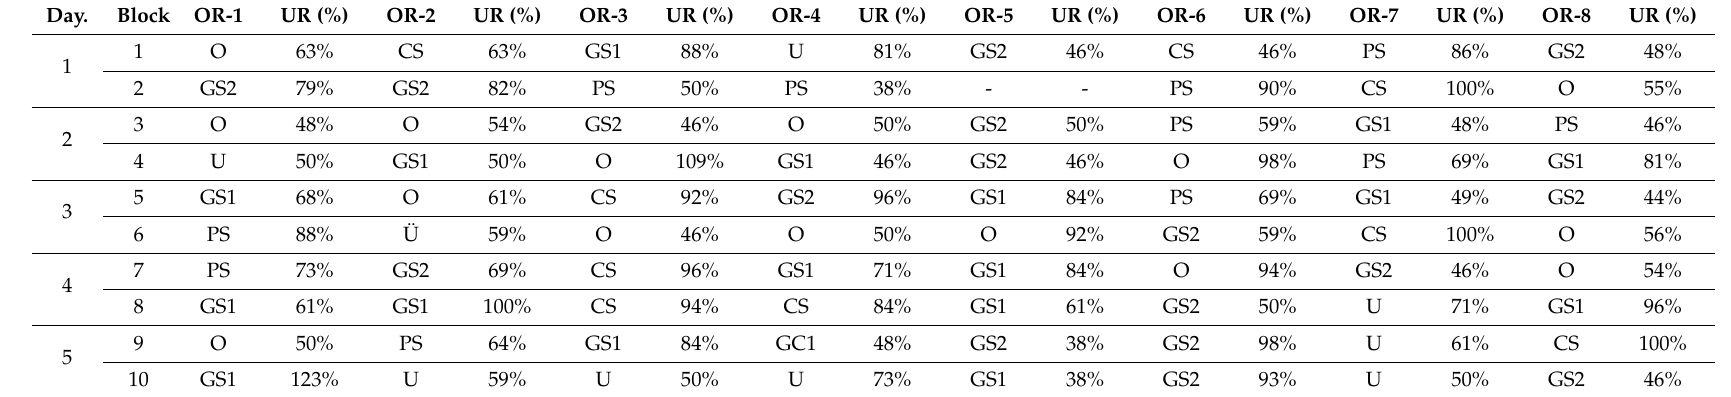
Table 6. Created schedule for Scenario 5 as a result of the constraint programming